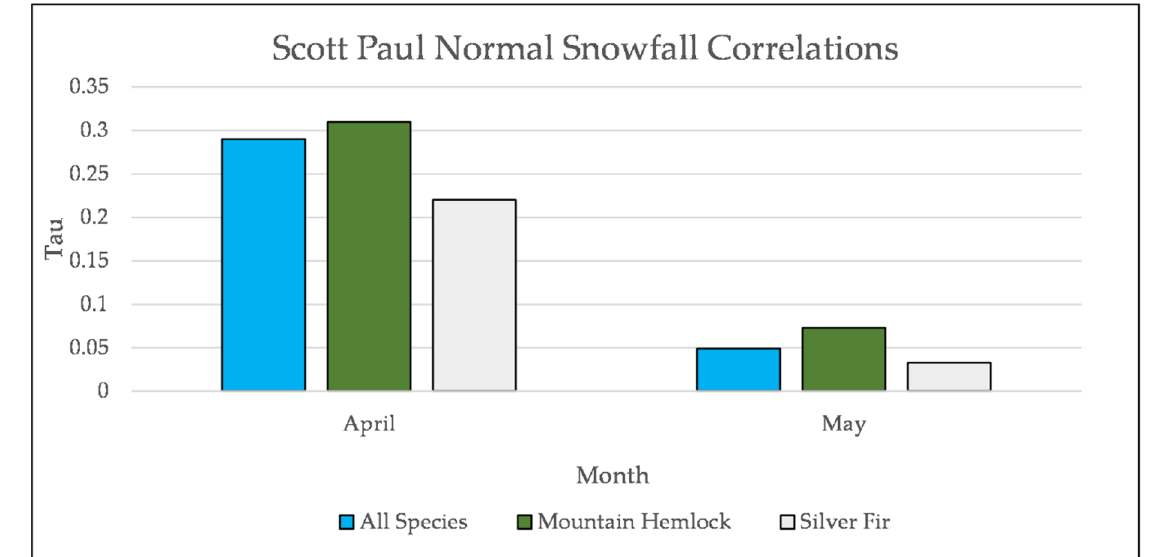
Figure A26. Normal Kendall’s correlation controlled for temperature between snowfall and establishment at Scott Paul. * = p -value < 0.05.